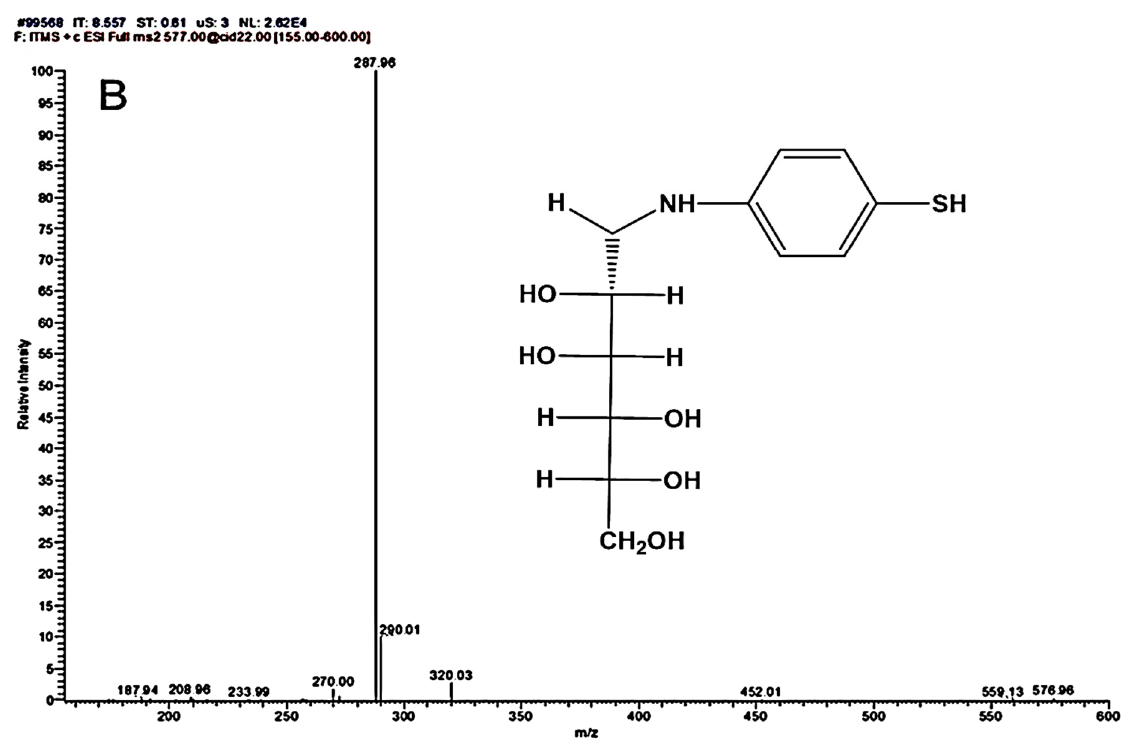
Figure 1. MS/MS of mannose derivatives ( A ) 4-NMBA and ( B ) 4-TNM ligands showing the different fragmentation patterns. Inset: chemical structures of 4-NMBA and 4-TNM.